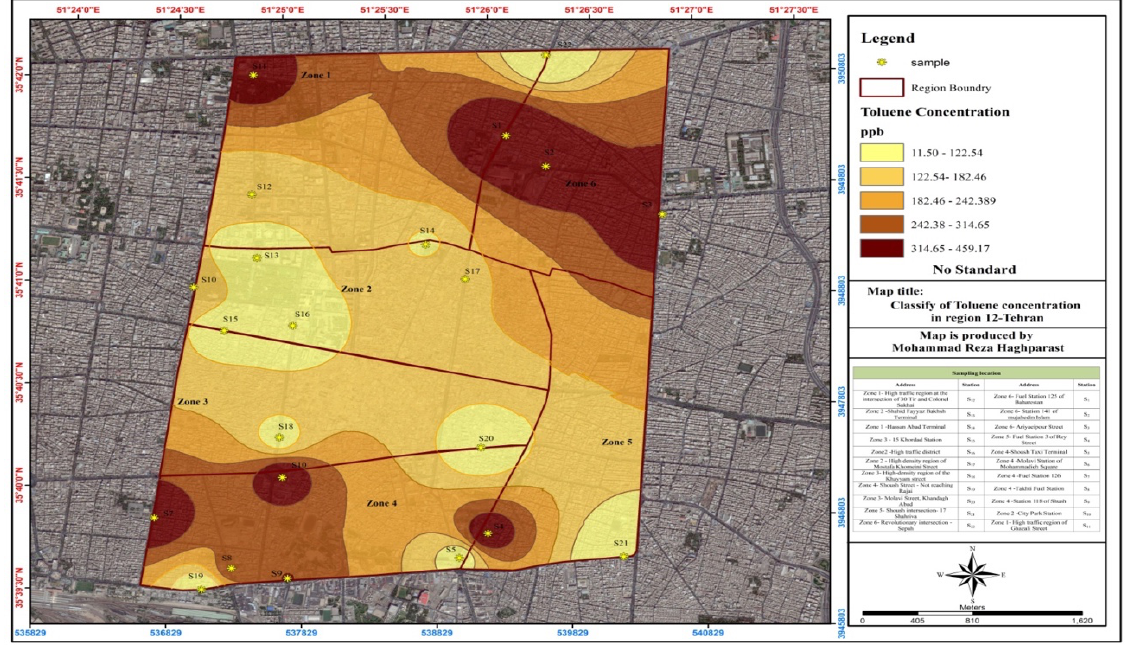
Figure 9. Zoning of Toluene concentration in the region on January,